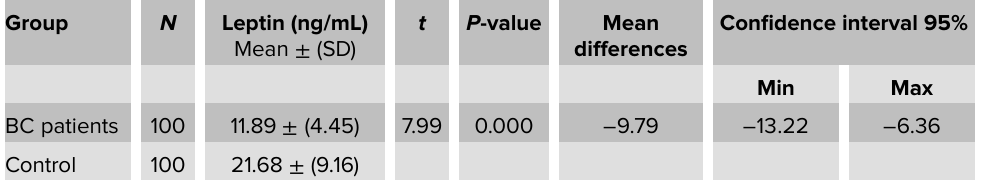
Table 1: Comparison of the mean leptin level between the two groups of the BC patients and the control group.